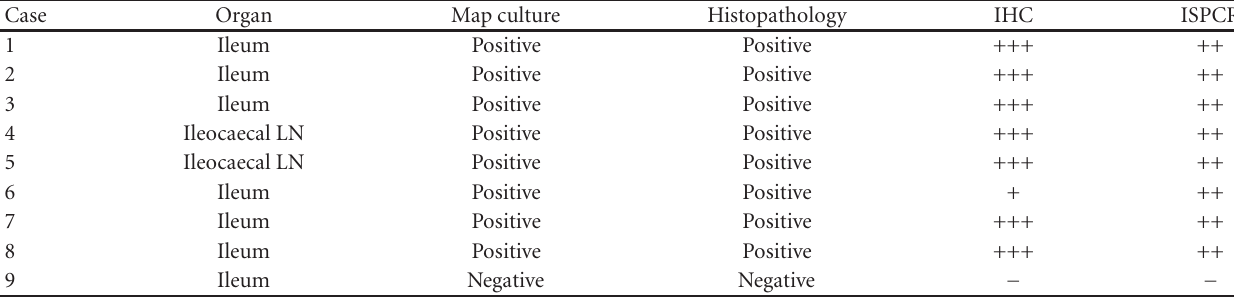
Figure 1: (a) Positive in situ PCR signal (small blue spots) inside the cytoplasm of epithelioid and Langhans giant cells (lamina propria, ileum). (b) Positive in situ PCR signal (small blue spots) inside the cytoplasm of macrophages (ileocaecal lymph node, cortex). (c) Positive immunostaining (brown color) inside the cytoplasm of epithelioid cells. Tissue’s architecture is perfectly conserved (lamina propria, ileum). (d) Positive in situ PCR signal inside the cytoplasm of an epithelioid cell. Interpretation of this slide became very di ffi cult due to damage on tissue’s architecture (lamina propria, ileum). Table 1: Analyzed samples and obtained